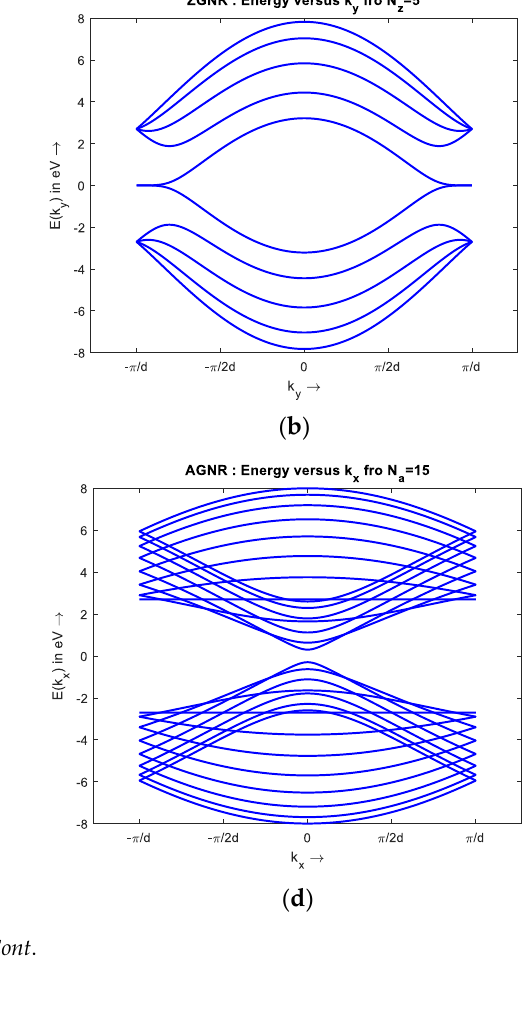
Figure 5. Energy dispersion. ( a ) Energy versus 𝑘 𝑦 ( 𝑘 𝑥 = 0 ); ( b ) energy versus 𝑘 𝑥 ( 𝑘 𝑦 = 0 ).